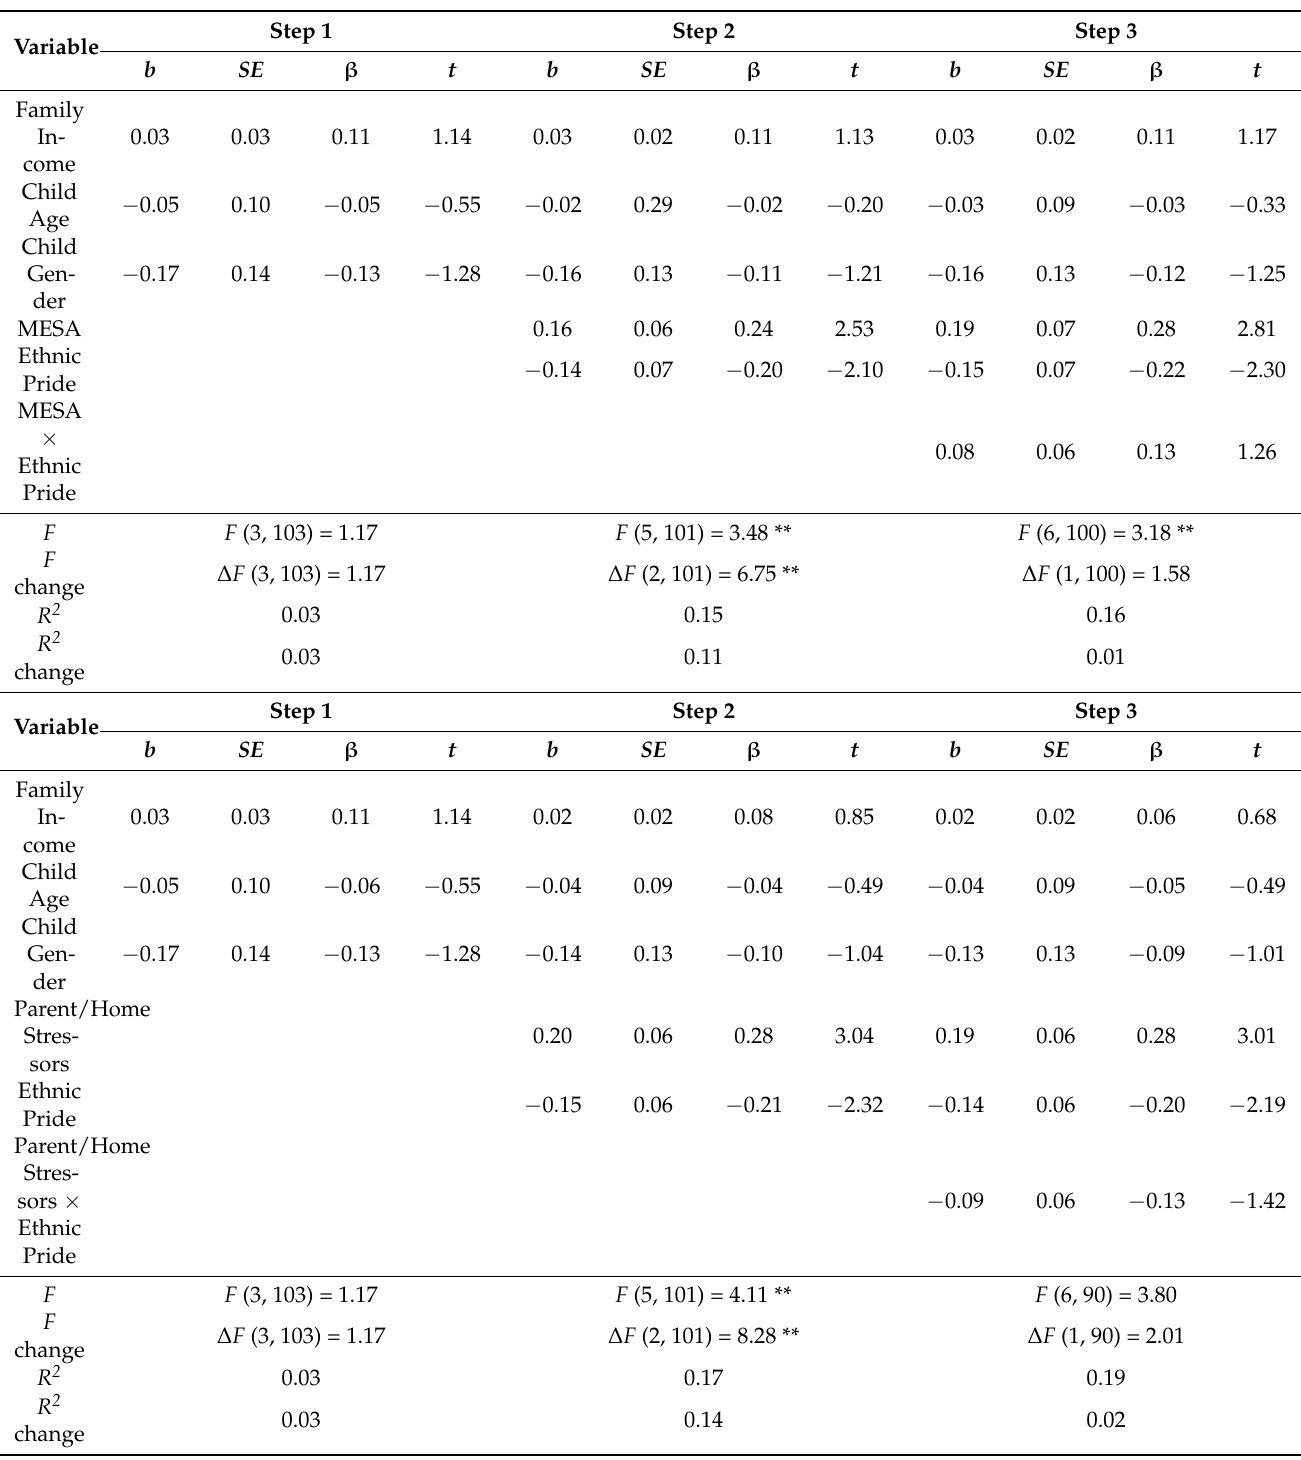
Table 3. Moderated regression analysis of the role of ethnic pride on child